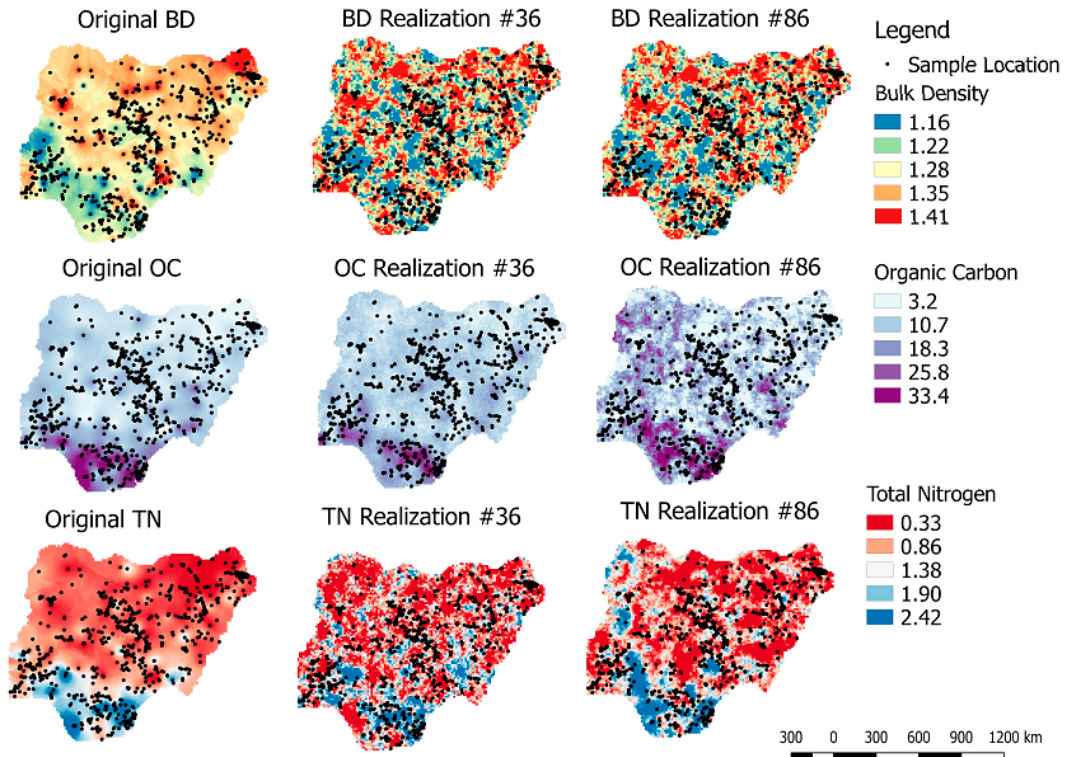
Figure 15. Original soil health indicators and simulations of the back-transformed simulated randomly selected realizations #36 (second column) and #86 (third column), using MAF (BD = bulk density (g/cm 3 ); OC = organic carbon (g/kg); and TN = total nitrogen (g/kg)).